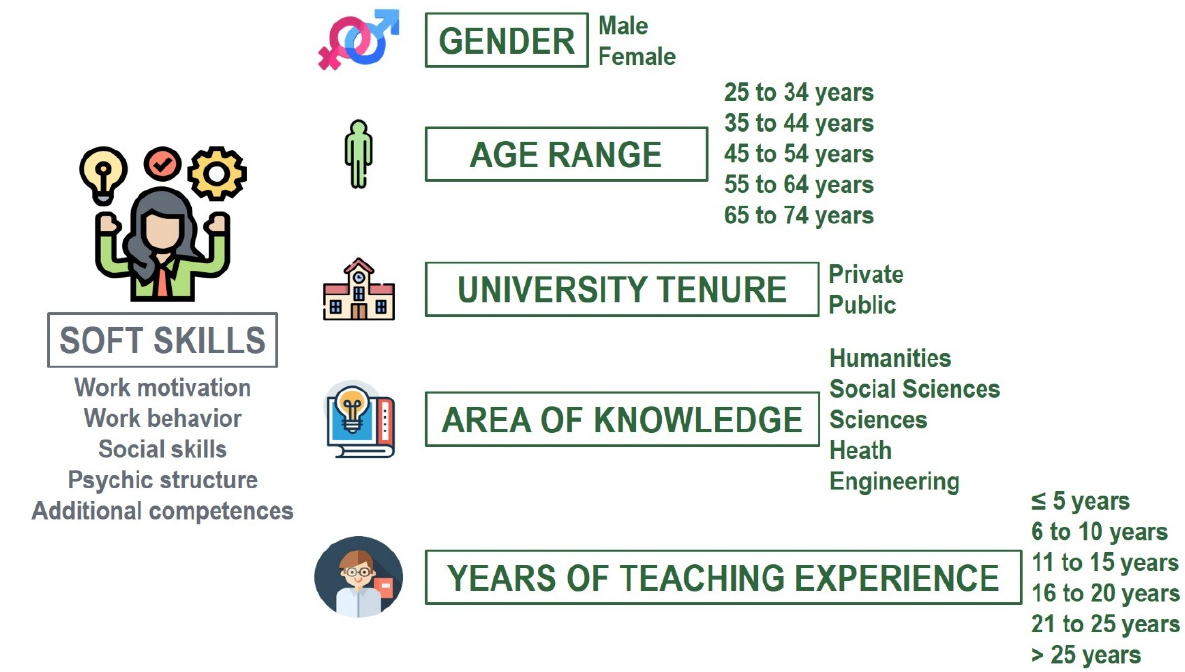
Figure 1. Scheme of the aspects analyzed in the statistical study.